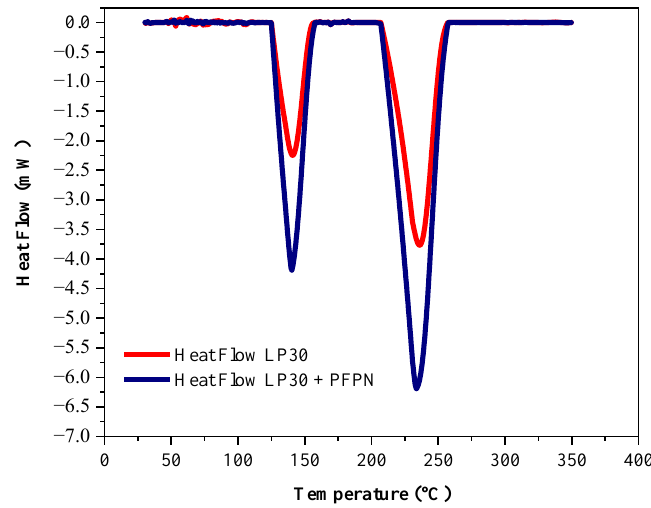
Figure 3. Endothermic curves of LP30 and LP30 + PFPN at β of 10 °C/min.